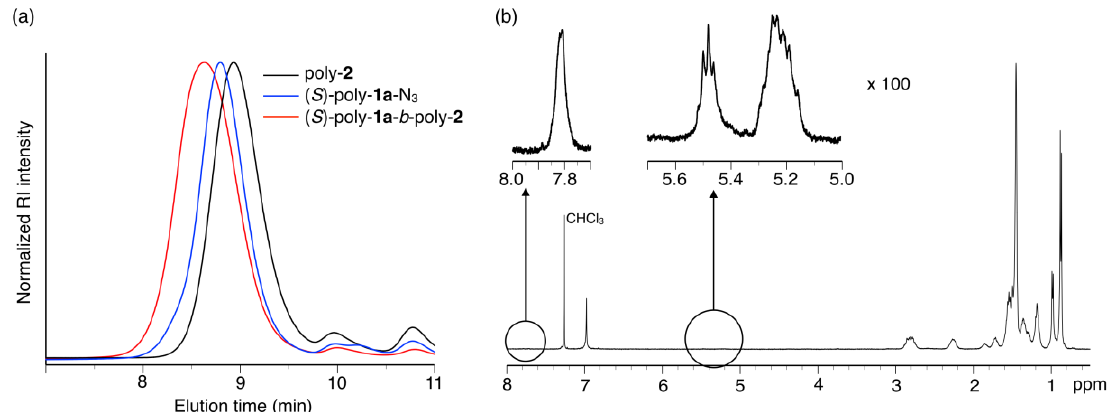
Figure 1. Results of the click reaction of ( S )-poly- 1a -N 3 with poly- 2 : ( a ) size exclusion chromatography (SEC) traces of ( S )-poly- 1a - b -poly- 2 , poly- 2 , and ( S )-poly- 1a -N 3 in tetrahydrofuran (THF) at 40 °C (PSt standard); ( b ) 1 H NMR spectrum of ( S )-poly- 1a - b -poly- 2 in CDCl 3 at rt.